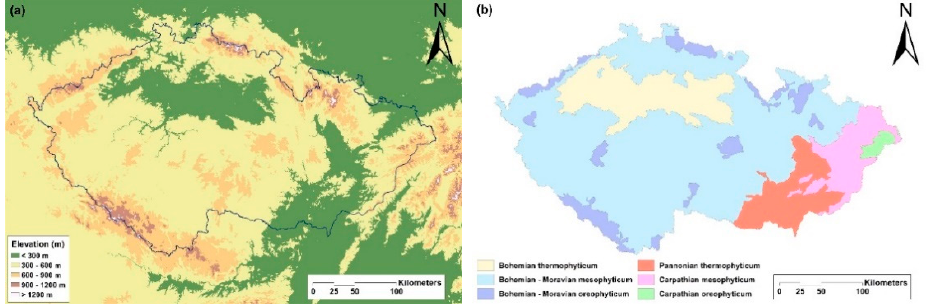
Figure 6. Maps of the Czech Republic showing: ( a ) the areas at different altitudes and ( b ) phytoge- ographical areas (taken and modified from Kaplan 2012).